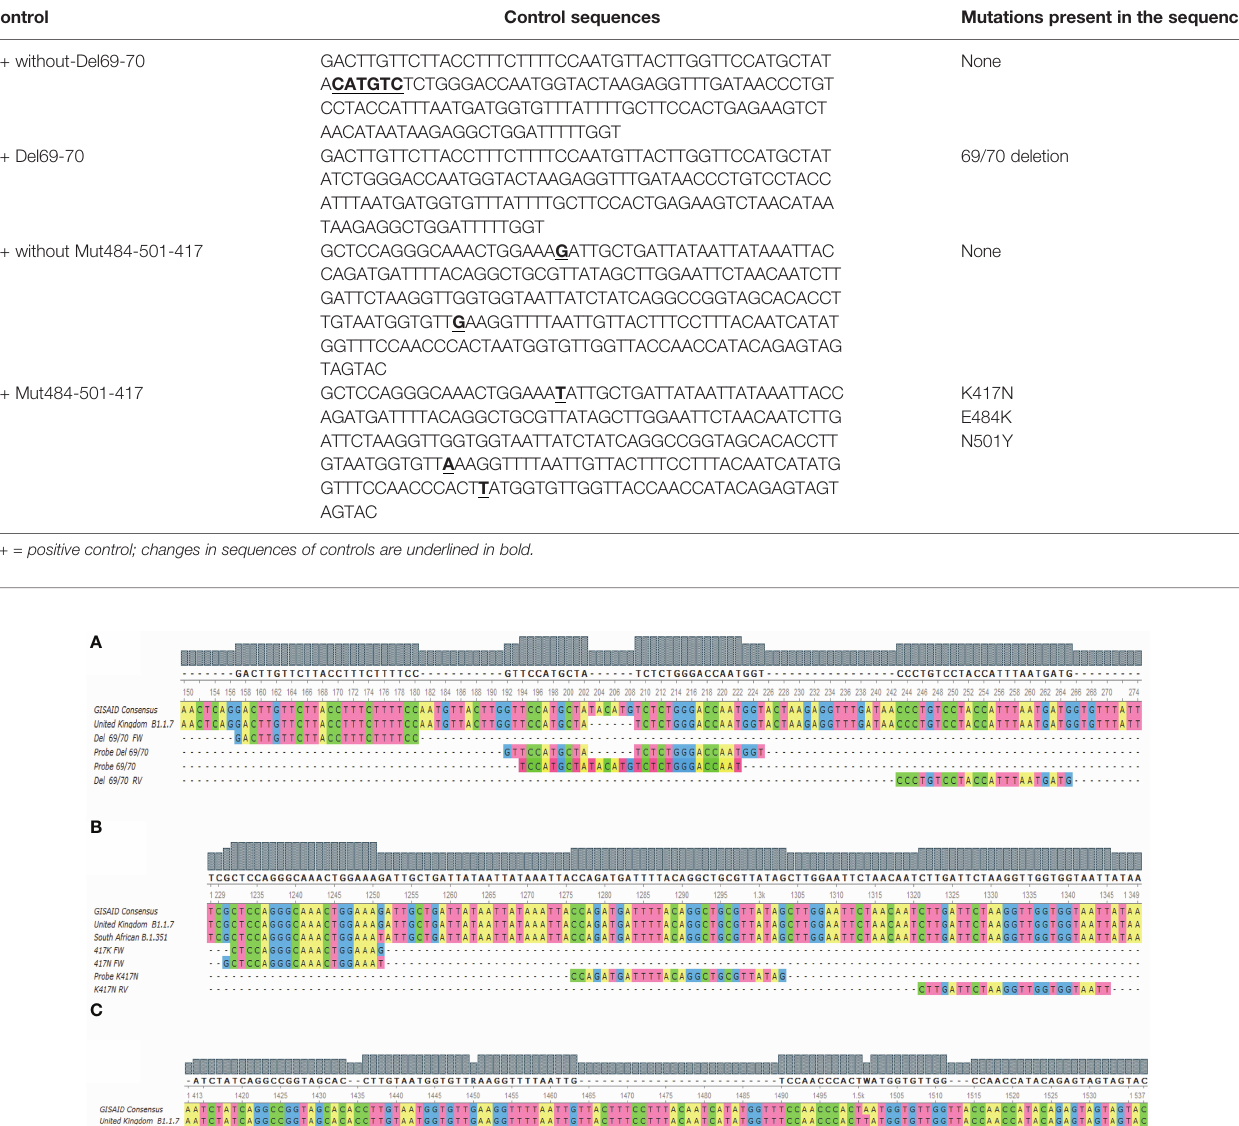
TABLE 2 | Synthetic DNA controls for tests.